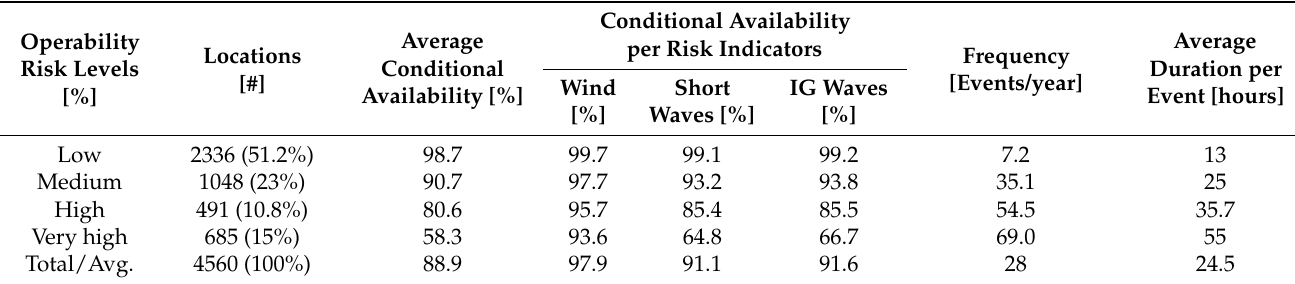
Table 3. Overview of the conditional availability of the 4560 locations, differentiated into risk indicators and event frequencies and duration and categorized in operability risk level